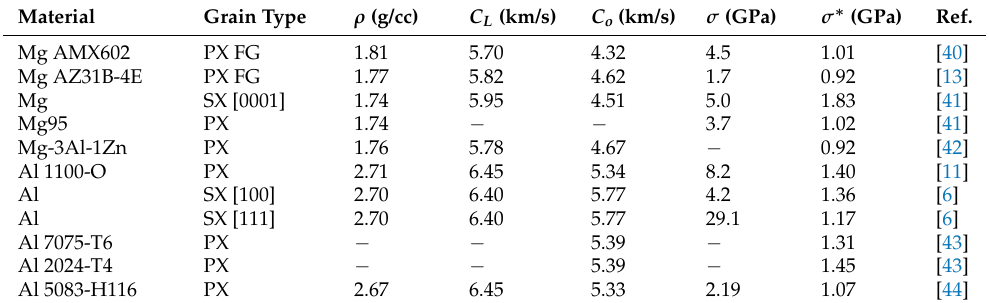
Table 1. Spall strength data of selected magnesium and aluminum systems. ρ , C L , C o , σ , and σ ∗ are density, longitudinal sound speed, bulk sound speed, peak shock stress, and spall strength, respectively.